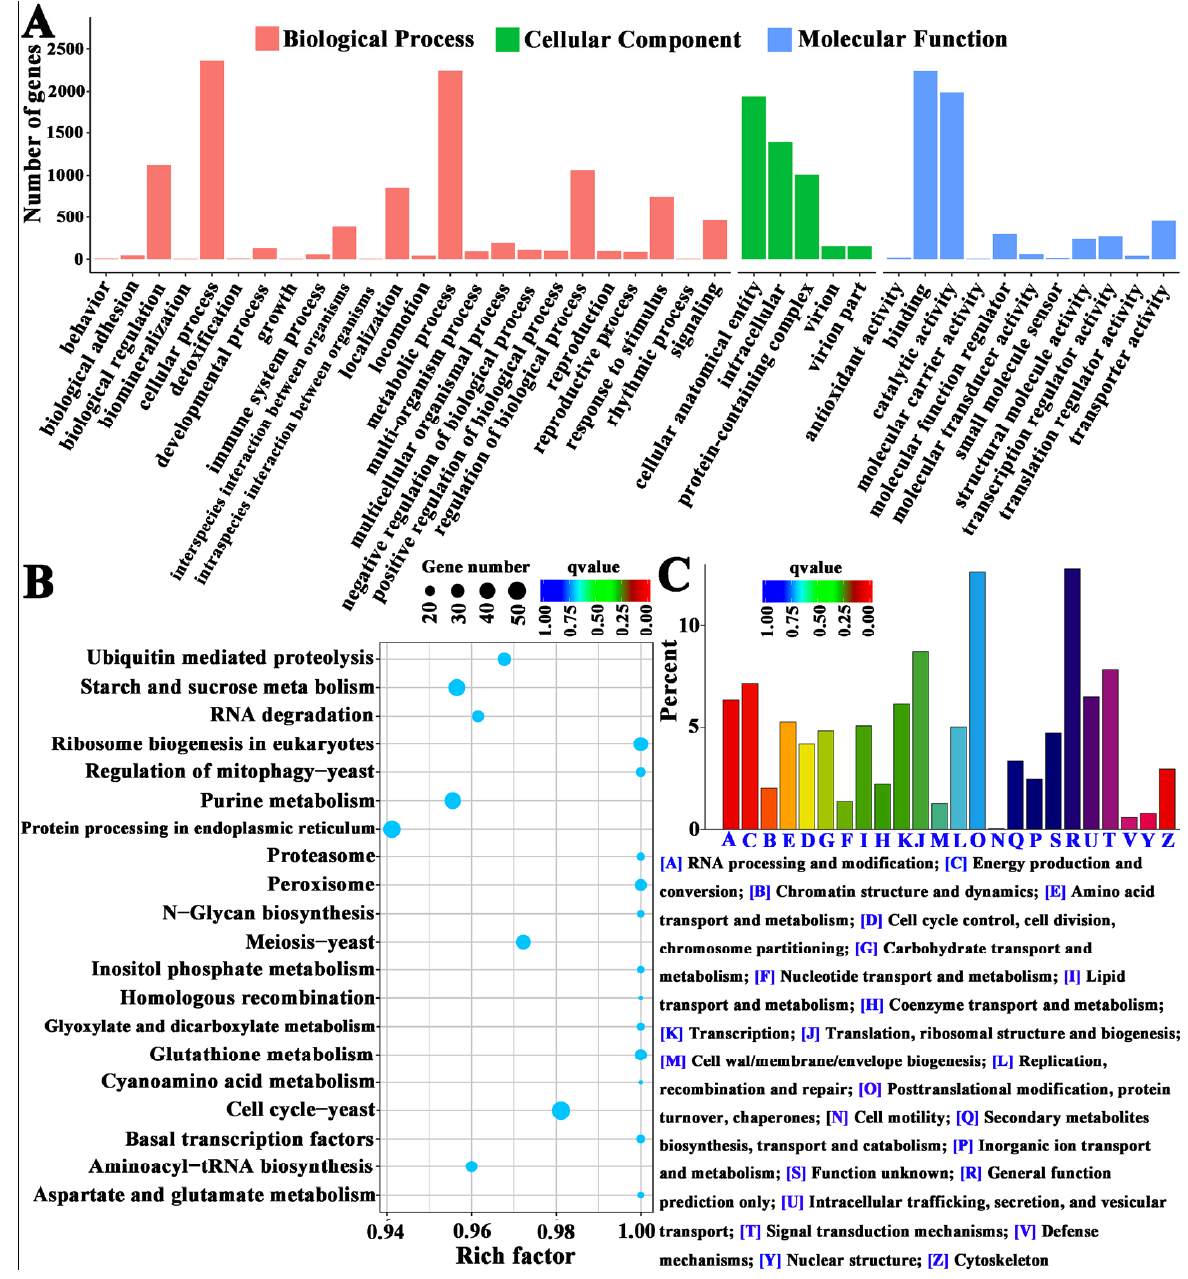
Figure 3. GO ( A ), KEGG ( B ), and KOG ( C ) enrichment analyses of DEGs. Moreover, the increase in biofilm synthesis by A. fumigatus induced by a low-iron condition is dependent on the CWI pathway because the receptor Wsc1 on the cell mem- brane in the CWI pathway is involved in the perception of biofilm synthesis [35,50]. In B. bassiana, bck1 , mkk1 , and slt2 in the CWI pathway can not only maintain cell integrity but can also positively regulate growth, sporulation, and host infectivity [26,51]. The deletion of yvmB inhibits the sporulation of Bacillus subtilis and leads to the disruption of the proteins involved in iron transport [36]. The protein encoded by the uvt3277 gene can transport iron ions [52]. In Ustilago maydis , the deletion of the urbs1 gene inhibits siderophore biosynthesis and limits iron assimilation [41]. The cmSIT1 gene is associated with siderophore-mediated transport